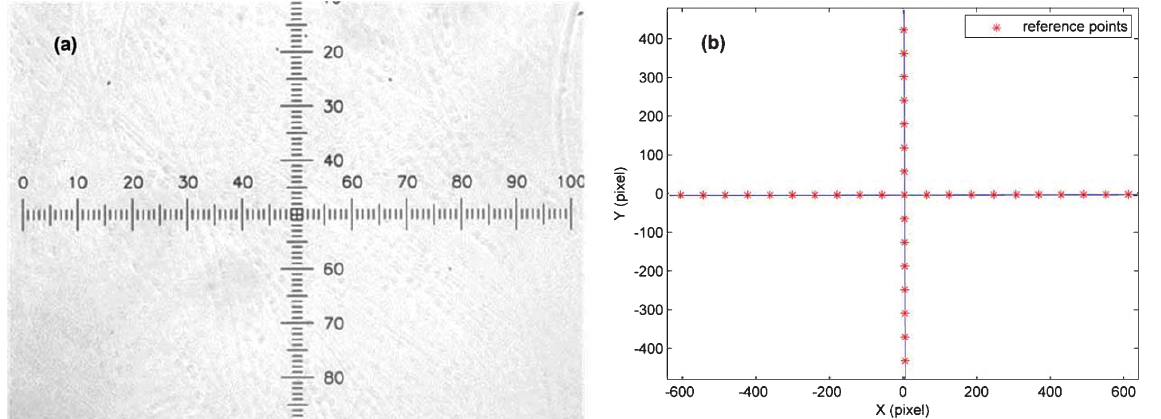
Fig. 3. Illustration for calculating the geometric distortion. (a) An example image of the 1mm in 0.01mm divisions crossed micrometer scale target, taken under the 10 × objective lens. (b) The corresponding map of the marks, which are the geometric centers of the marks. The blue lines represent the distance from each mark to the scales’ center.